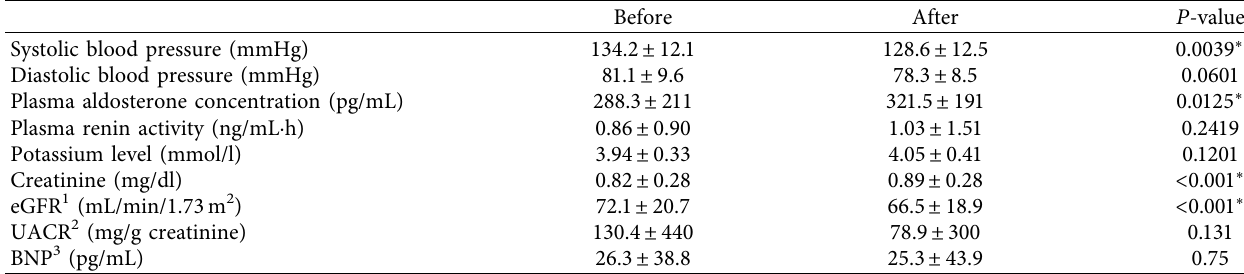
Table 2: Changes of blood pressure and biochemical parameters of PA patients before and after esaxerenone treatment. Data are mean ± SD. Before